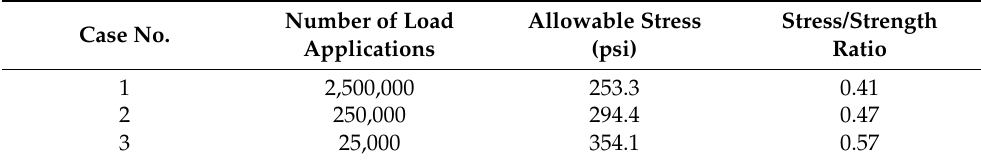
Table 13. Allowable stresses and stress/strength ratios corresponding each number of load applica- tions (1 psi = 6.89